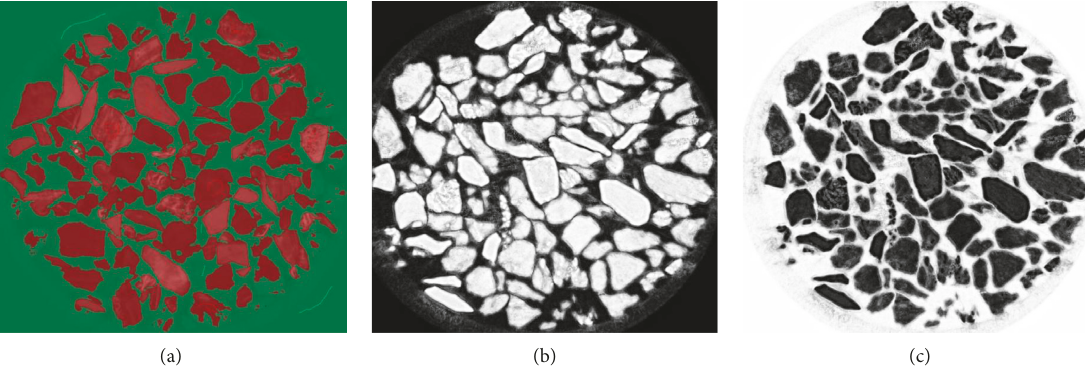
Figure 4: Training of small-scale CT images using trainable Weka segmentation tool. This figure (a) presents the segmented image after applying the forest classifier; (b) presents foreground (particle); and (c) presents background